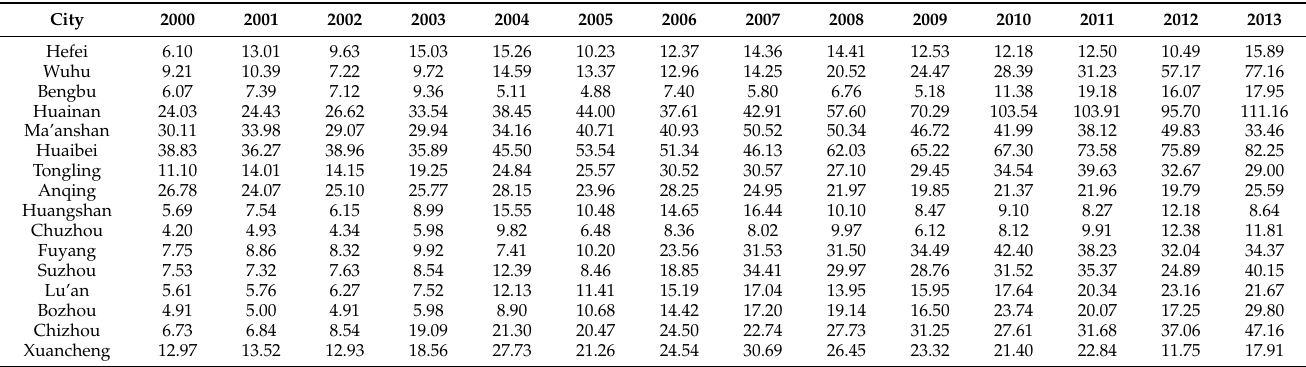
Table 4. Changes in the CEIIL of prefecture-level cities in Anhui Province from 2000 to 2013. Unit: 10 thousand tons /km 2